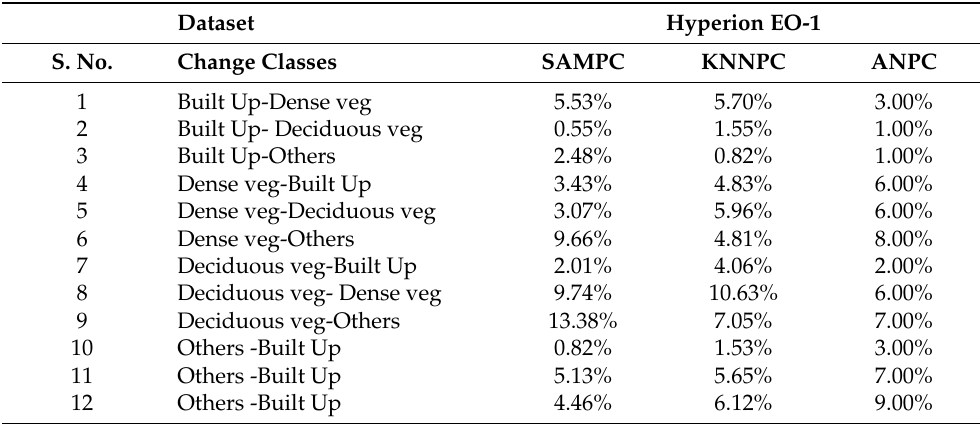
Table 3. Representation of change area (in percentage) computed from SAMPC, SVMPC, and ANPC using Hyperion